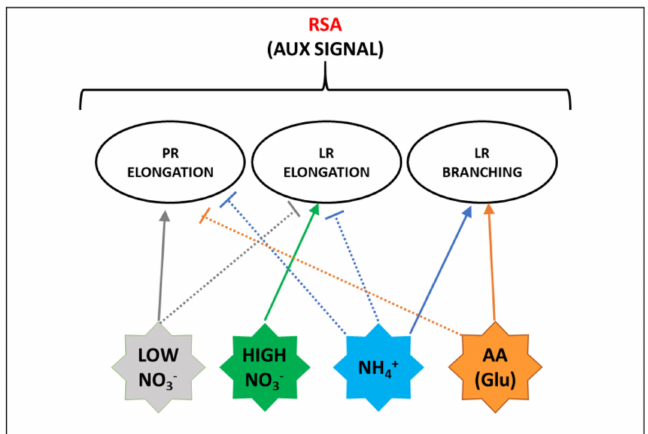
Figure 4. Scheme of the main effects of the different N forms on the responses affecting root system architecture (RSA) that are also related to auxin (aux) signal. Full lines indicate positive effects, dashed lines indicate negative effects. Details are explained in the